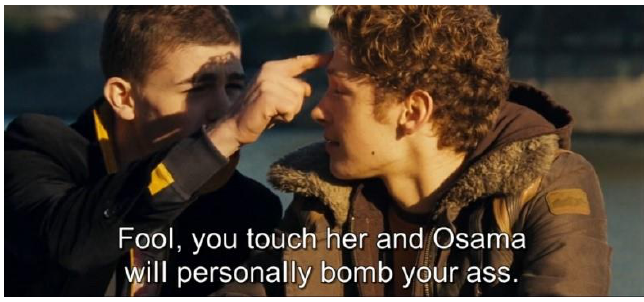
Figure 2 Zarqa et François parle du harcèlement aux